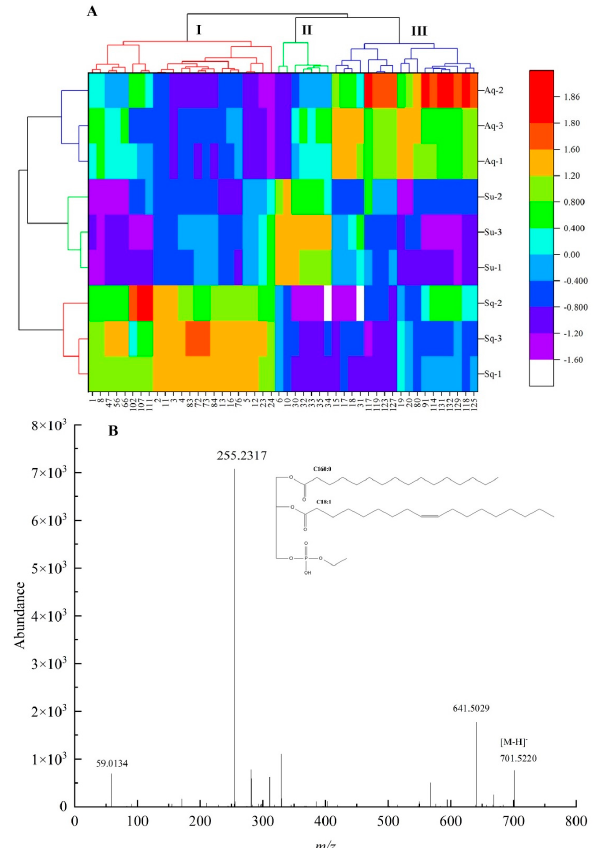
Figure 4. ( A ) Represented the thermogram of lipid components with significant differences among the three extraction methods, and ( B ) represented the mass spectrogram of PETOH 34:1|PETOH 16:0 _18:1 in negativity mode.